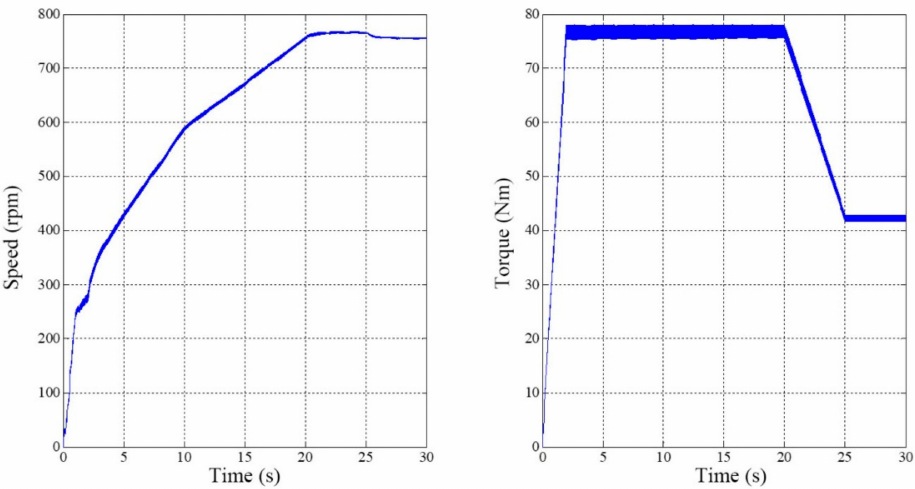
Figure 12. The speed and torque of the SRM in the starting process under the heavy-load condition.